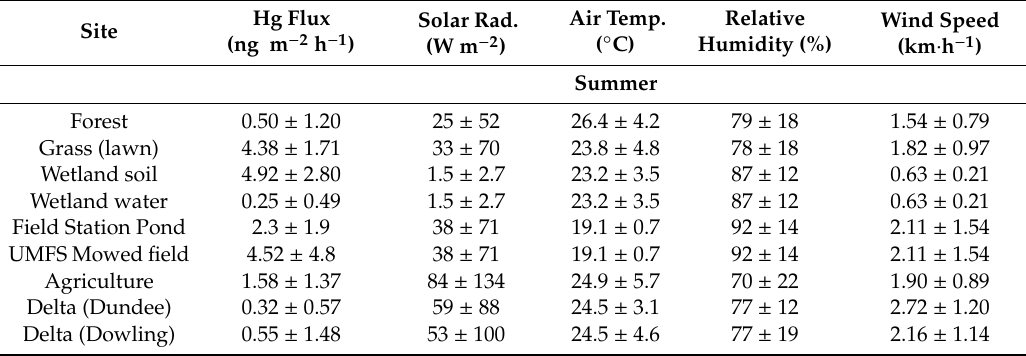
Table 4. Mean gaseous elemental mercury (GEM) fluxes and meteorological parameters for the study sites during the measurement campaign. Winter measurements were not collected at the wetland due to logistical issues. A single set of meteorological measurements was collected at the wetland and University of Mississippi Field Station sites.